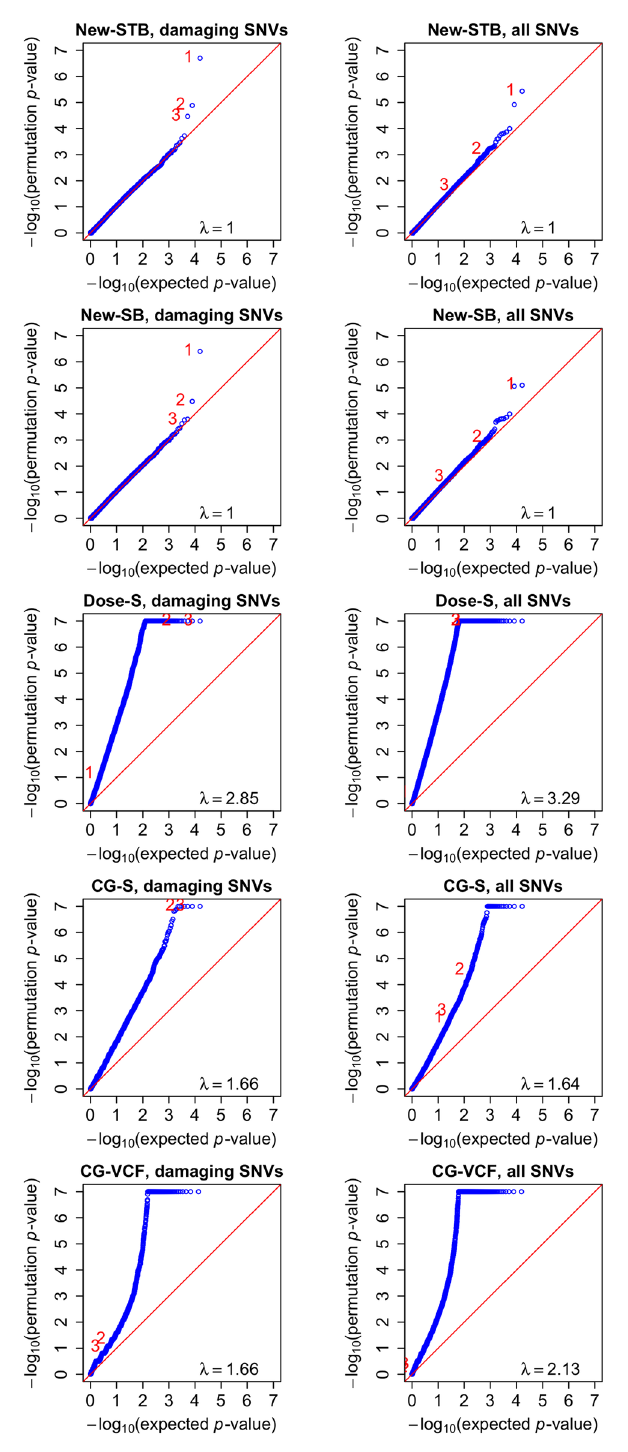
Fig 3. Quantile – quantile plots of − log 10 ( p -values) for the weighted burden test using damaging SNVs only (left side) and all SNVs (right side) in the analysis of the UK10K data. The top three genes identified by New-STB using damaging variants only are marked as 1 –